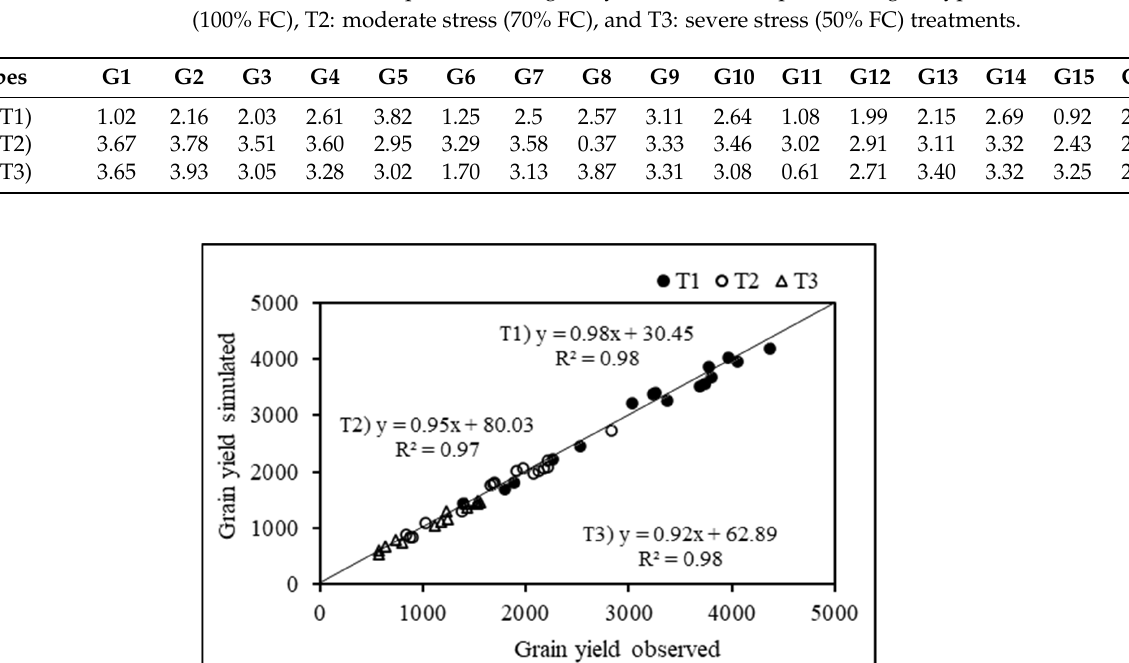
Figure 5. Simulated versus observed days to anthesis ( a ) and days to maturity ( b ) for sixteen upland rice genotypes under T1: control (100% FC), T2: moderate stress (70% FC), and T3: severe stress (50% FC) treatments in the yield assessment experiment. Table 2. RMSEn computed for the grain yield of sixteen upland rice genotypes under T1: control